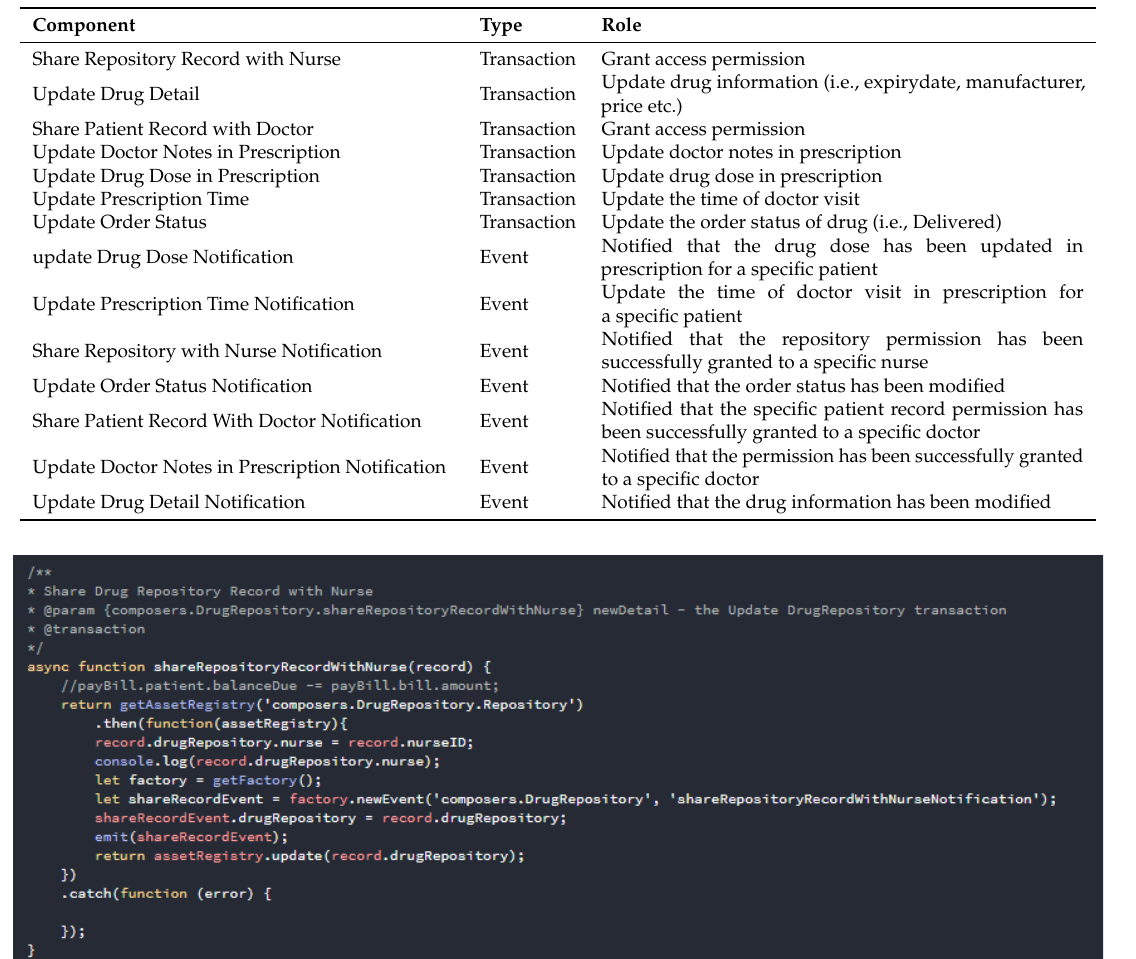
Table 4. Transaction and event definition of the proposed drug supply chain management in a medical blockchain.